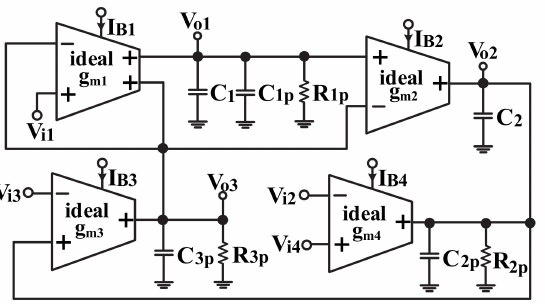
Figure 5. The influence of parasitic components on the proposed VM